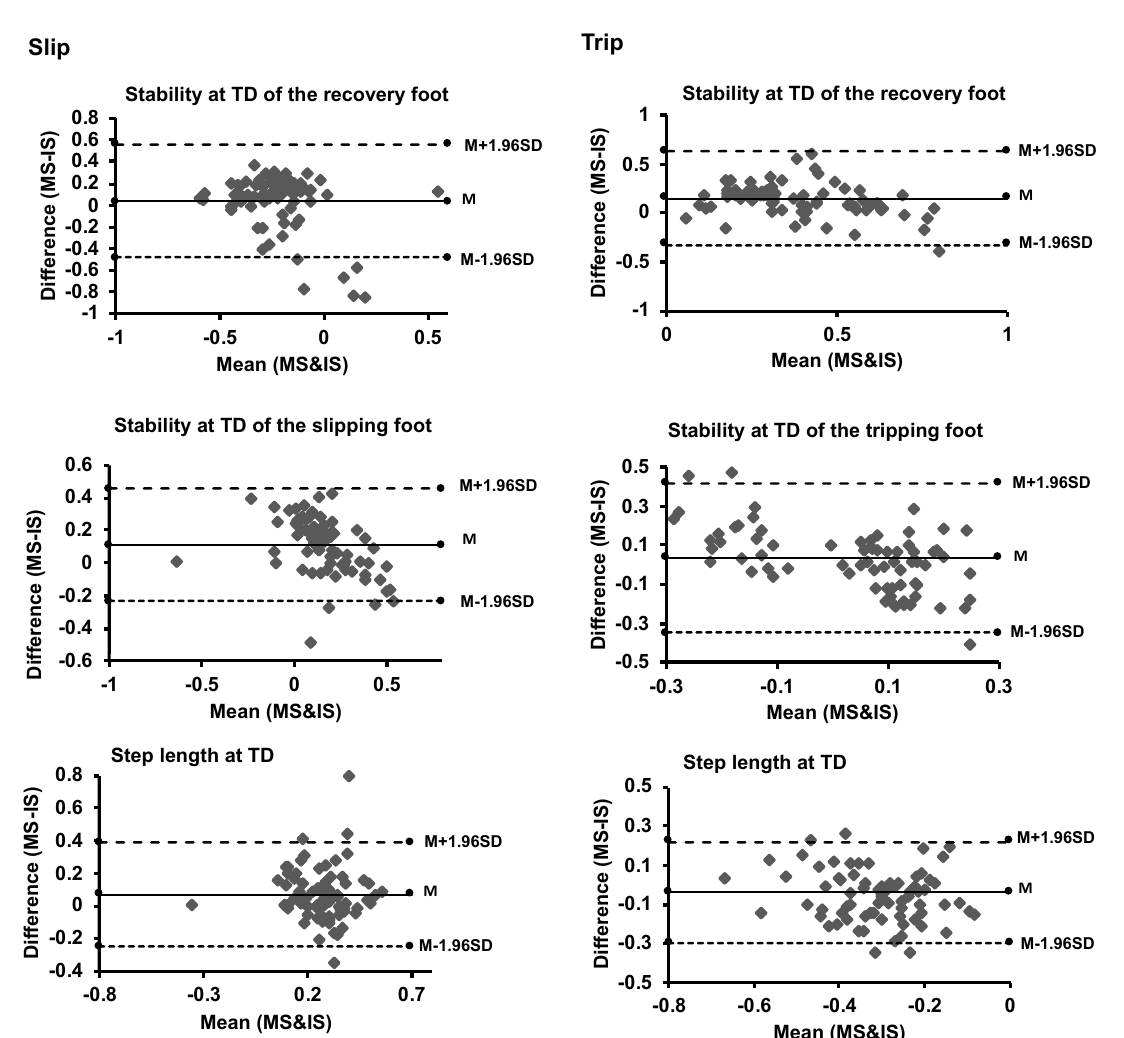
Figure 1. Bland-Altman plots of postural stability measures (of the Stance Perturbation Test) for motion (MS) and inertial sensor (IS) systems. The solid line represents the mean (M), while the two dash lines above and below M represent the upper (M + 1.96 SD) and lower (M − 1.96 SD) limits of agreements (1.96 standard deviations), respectively.